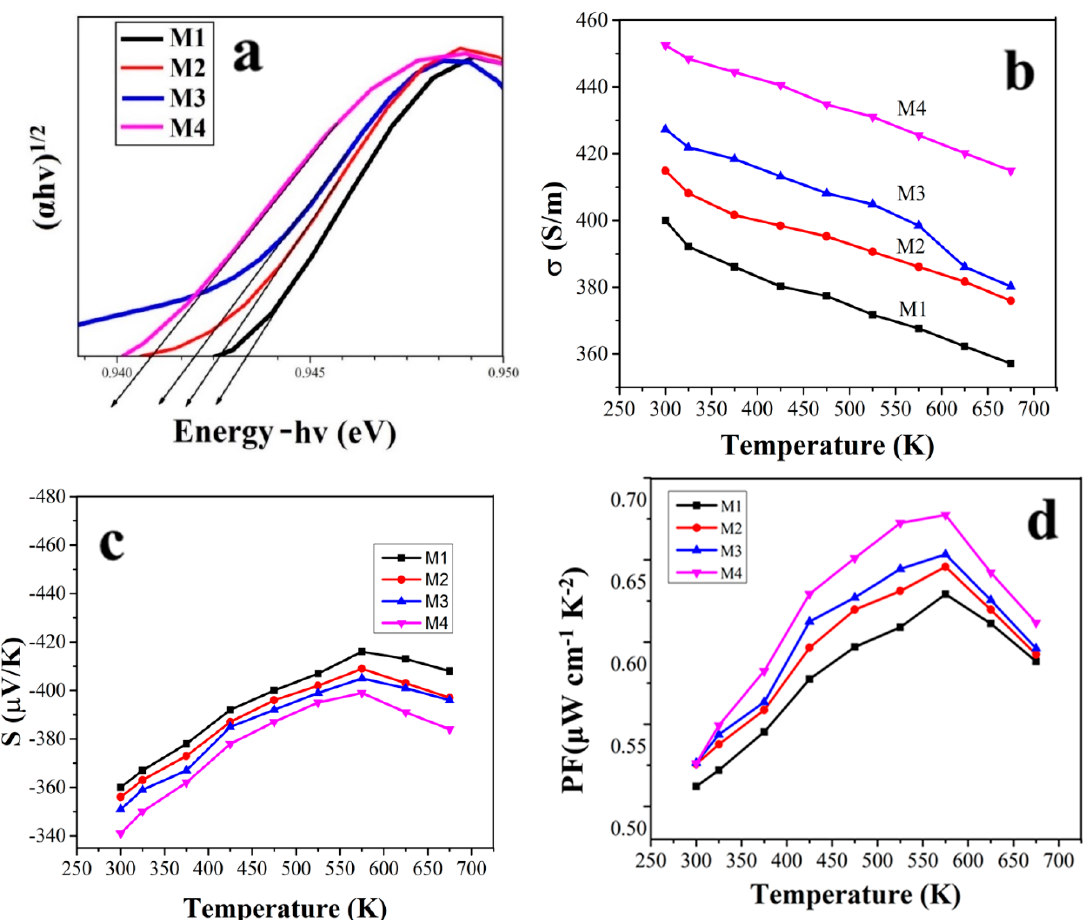
Figure 4. ( a ) Band gap analysis in form of a Tauc plot of the synthesized four samples. Temperature dependent electrical conductivity ( b ), Seebeck coefficient ( c ), and power factor ( d ) of the solvothermally synthesized SnSe 2 thin films.